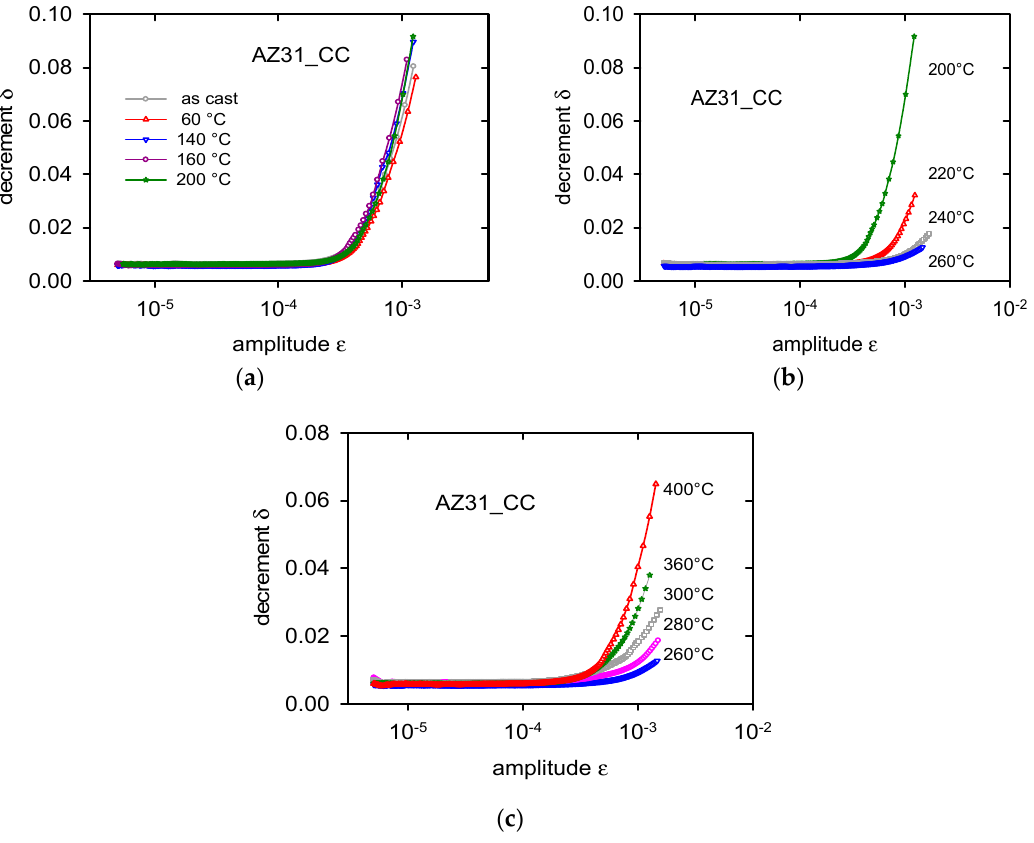
Figure 3. Amplitude dependences of decrement measured for lower temperatures from 60 up to 200 °C ( a ); for medium temperatures from 200 up to 260 °C ( b ); and for high temperatures from 260 up to 400 °C ( c ). Indicated temperatures are the upper temperatures of the quenching cycle.